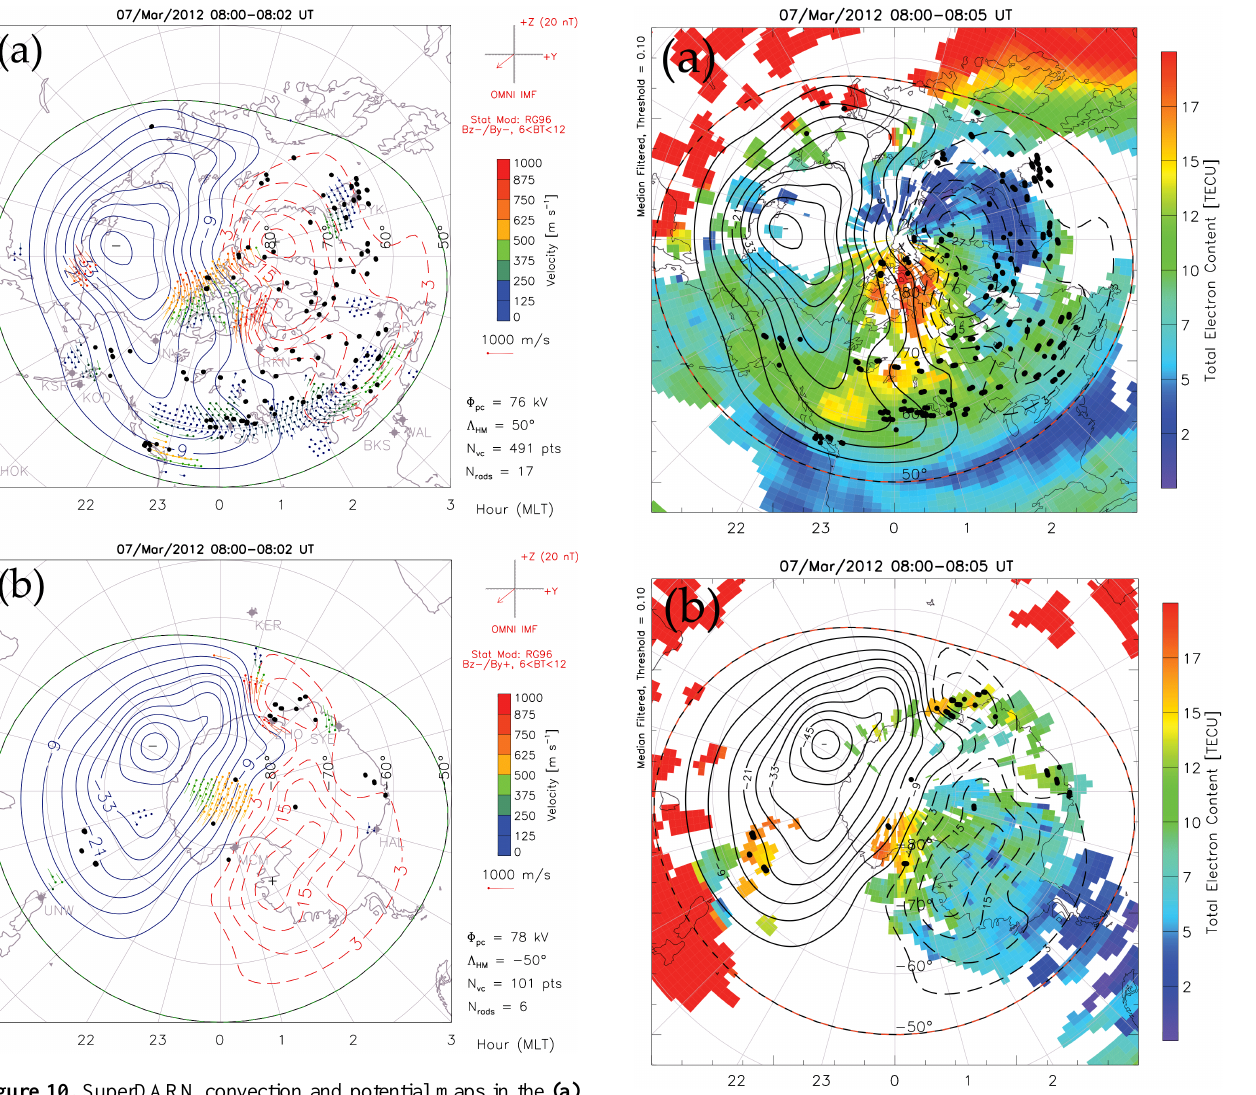
Figure 11. The 5min median-filtered TEC mapped in coordinates of AACGM latitude and MLT in the (a) Northern and (b) Southern Hemisphere on 7 March between 08:00 and 08:05UT. The TEC map is overlaid with the SuperDARN potential map and IPPs (black dots) for σ (cid:56) >0.1rad or sDPR>2mms − 1